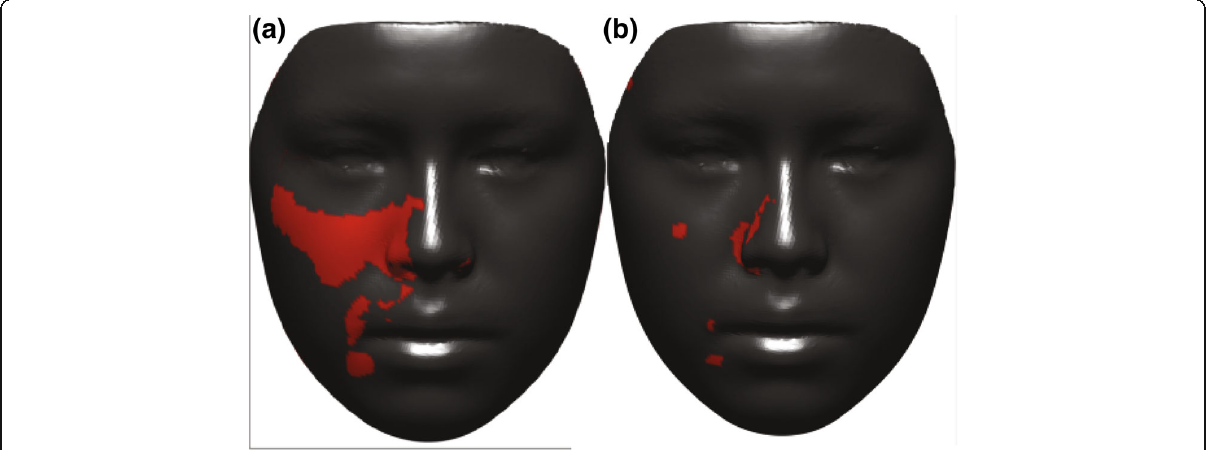
Fig. 10 P-maps between T0 (initial, right before MSE placement) x and T1 (immediately after expansion) time points for right side expanded group only with p < 0.05 ( a ) and p < 0.01 ( b